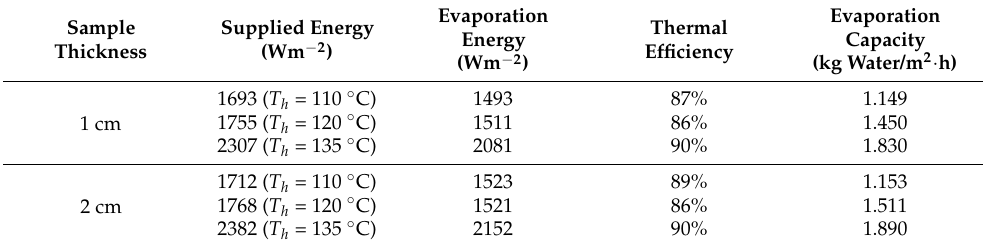
Table 5. Thermal drying parameters and